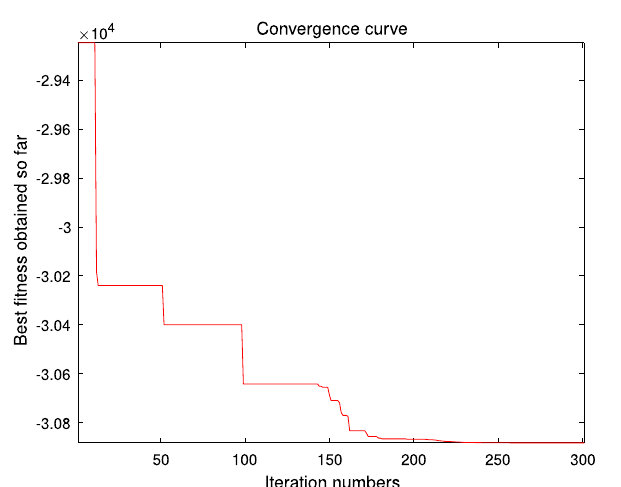
Figure 10. Convergence curve for Himmelblau’s constraint problem.